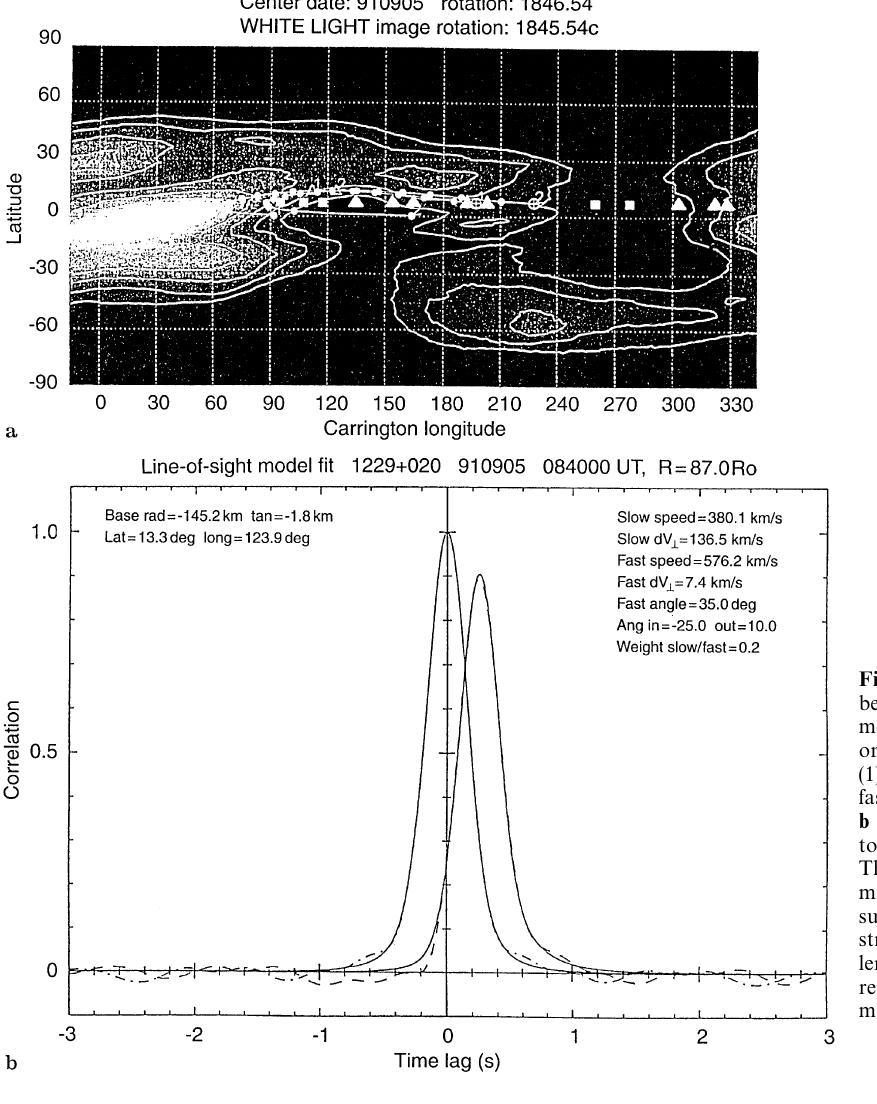
Fig. 12. a White-light map for 5 Septem- ber 1991 showing the line of sight for measurementsof 1229 # 020 back-projected onto the map with assumed velocities of (1) 800 km s (cid:126)(cid:49) and (2) 400 km s (cid:126)(cid:49) . The fast stream is overtaking the slow stream; b IPS correlation function corresponding to a , analysed using the line of sight model. The fast stream is much slower and causes much more scintillation than expected, suggesting that the fast stream and the slow stream are interacting to produce a turbu- lent compression zone. The dashed line represents the data and the solid line the model